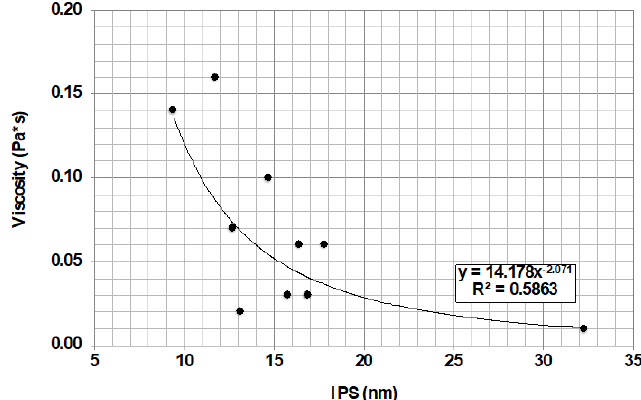
Figure 4. Effect of IPS on viscosity of cement